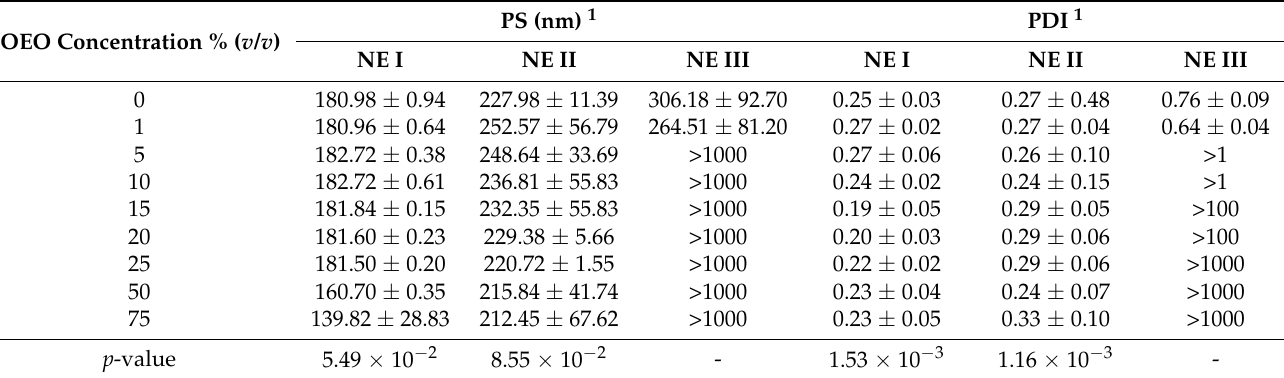
Table 2. Particle size (PS) and polydispersity index (PDI) of NE I, II, and III for increasing oregano essential oil (OEO)